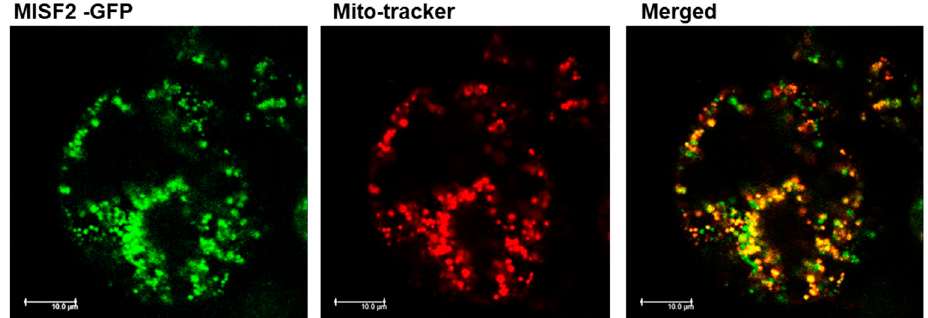
Figure 2. MISF2 is localized to the mitochondria. Arabidopsis plant cells were transformed with a construct expressing the GFP fused in frame to the N-terminal region (i.e., 203 amino acids) of the MISF2 protein. The fluorescence corresponding to the GFP (green, left), the MitoTracker ® marker (red, center), and the merged signals (right) are shown. Bars = 10 μ m.